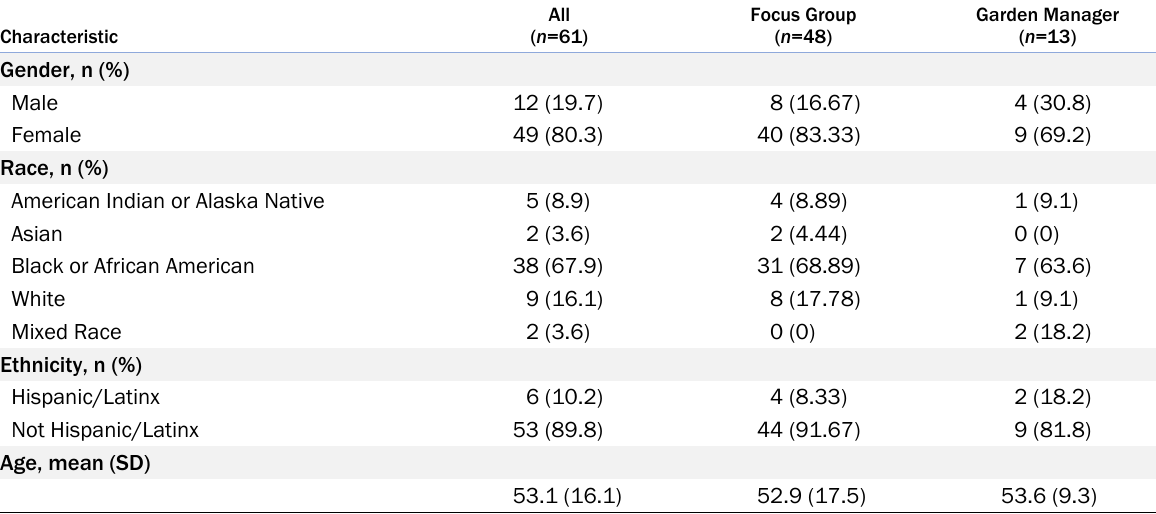
Table 1. Participant Demographic Characteristics